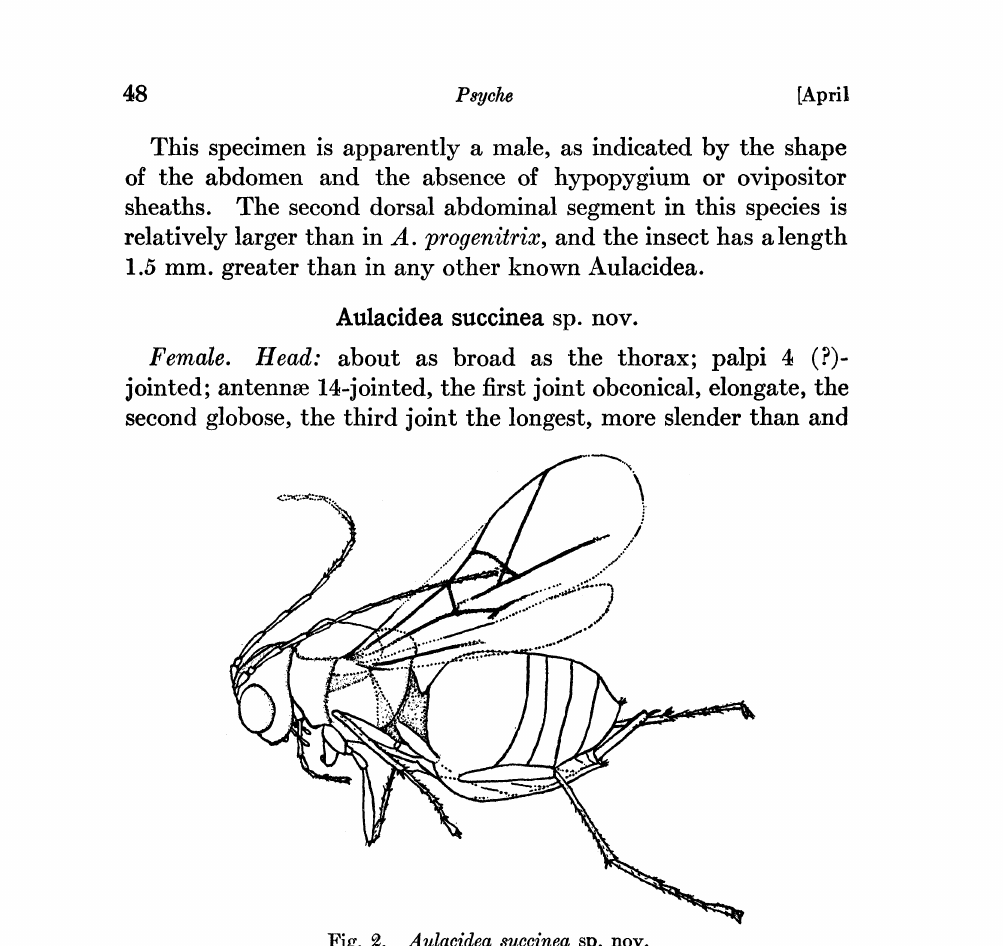
. Aulacidea succinea sp. nov. Fig. Thorax: distinct parapsidal Abdomen: with plates 2-6 visible,